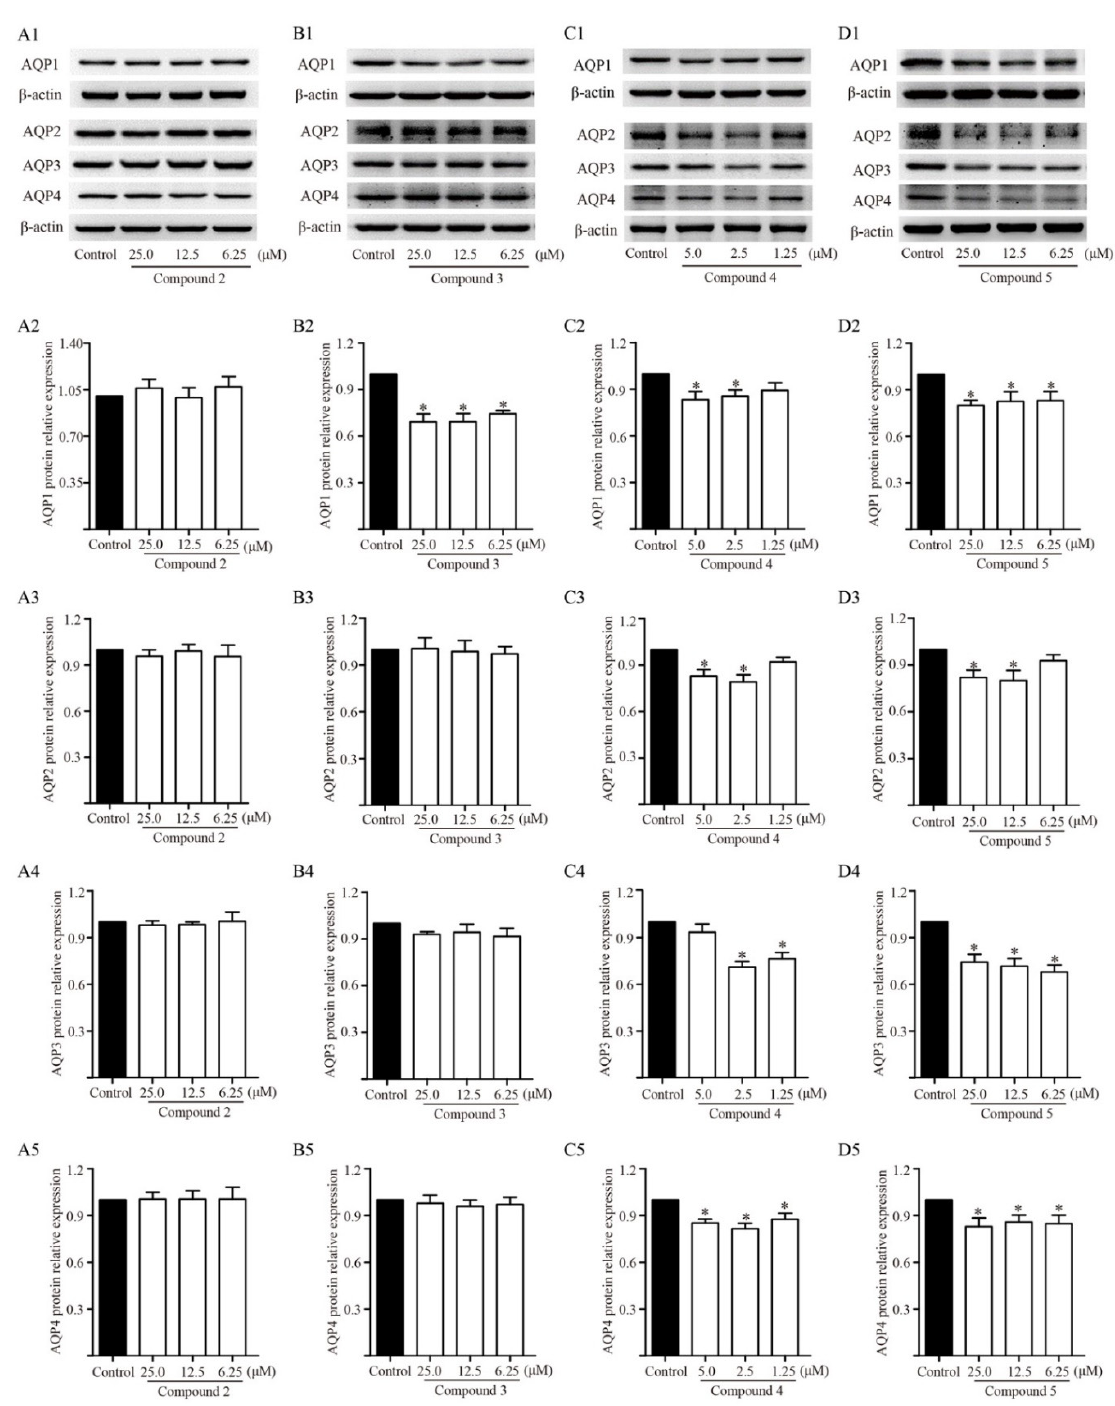
Figure 8. Effects of compounds 2 , 3 , 4 and 5 on protein expression levels of aquaporin (AQP)-1 in human kidney-2 cells (HK-2), and AQP2, AQP3 and AQP4 in murine inner medullary collecting duct cells (mIMCD3). ( A1 – A5 ) Western blot bands and protein relative expression of AQP1, AQP2, AQP3 and AQP4 after compound 2 administration. ( B1 – B5 ) Western blot bands and protein relative expression of AQP1, AQP2, AQP3 and AQP4 after compound 3 administration. ( C1 – C5 ) Western blot bands and protein relative expression of AQP1, AQP2, AQP3 and AQP4 after compound 4 administration. ( D1 – D5 ) Western blot bands and protein relative expression of AQP1, AQP2, AQP3 and AQP4 after compound 5 administration. The data are represented as the mean ± SD, n = 3, * p < 0.05 vs. control group (Mann–Whitney U test). Compound 2 : ent-11 α - hydroxyabicta-8(14),13(15)-dien-16,12-olide; compound 3 : jolkinolide B; compound 4 : euphebracteolatin A; compound 5 : fischeria